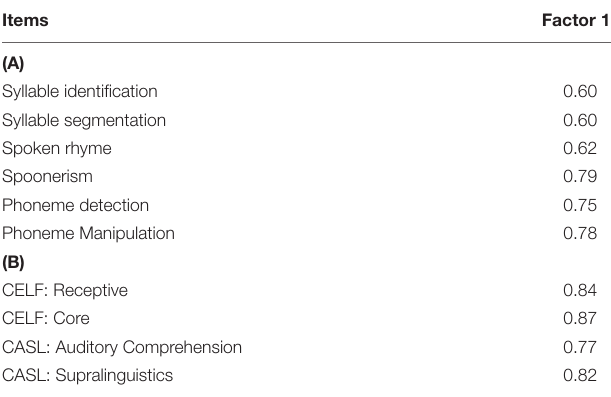
TABLE 3 | Factor loadings and communalities based on a (unrotated) principal components analysis for six items from the (A) QUIL subtests and (B) language measures from CELF-IV and CASL ( N =